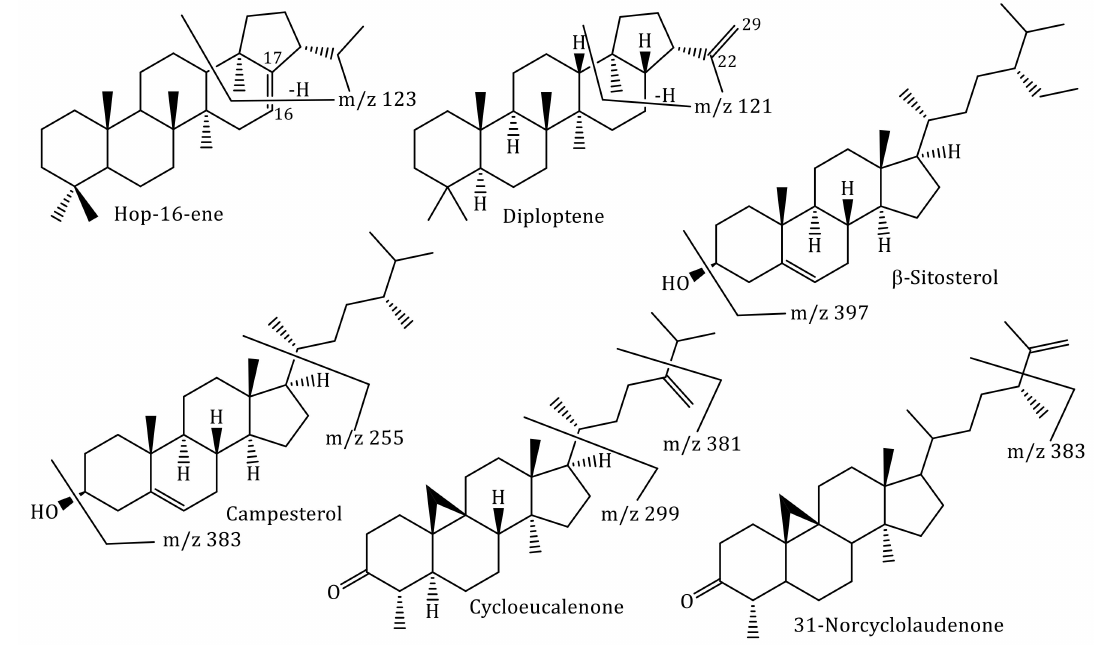
Figure 3. Chemical structure of some of the identified terpenoids and some of the most significant